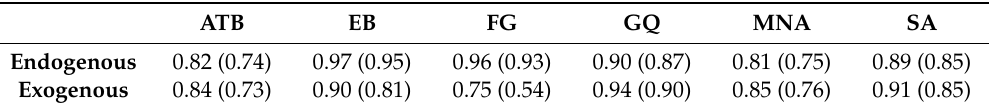
Table A1. A summary the R 2 (and Adjusted R 2 ) values for the best fitting models for all observers and experiments.